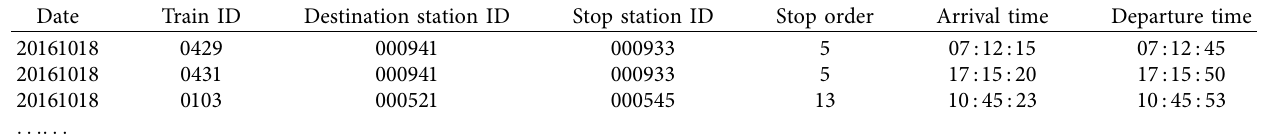
Table 2: Necessary elements of train diagram.